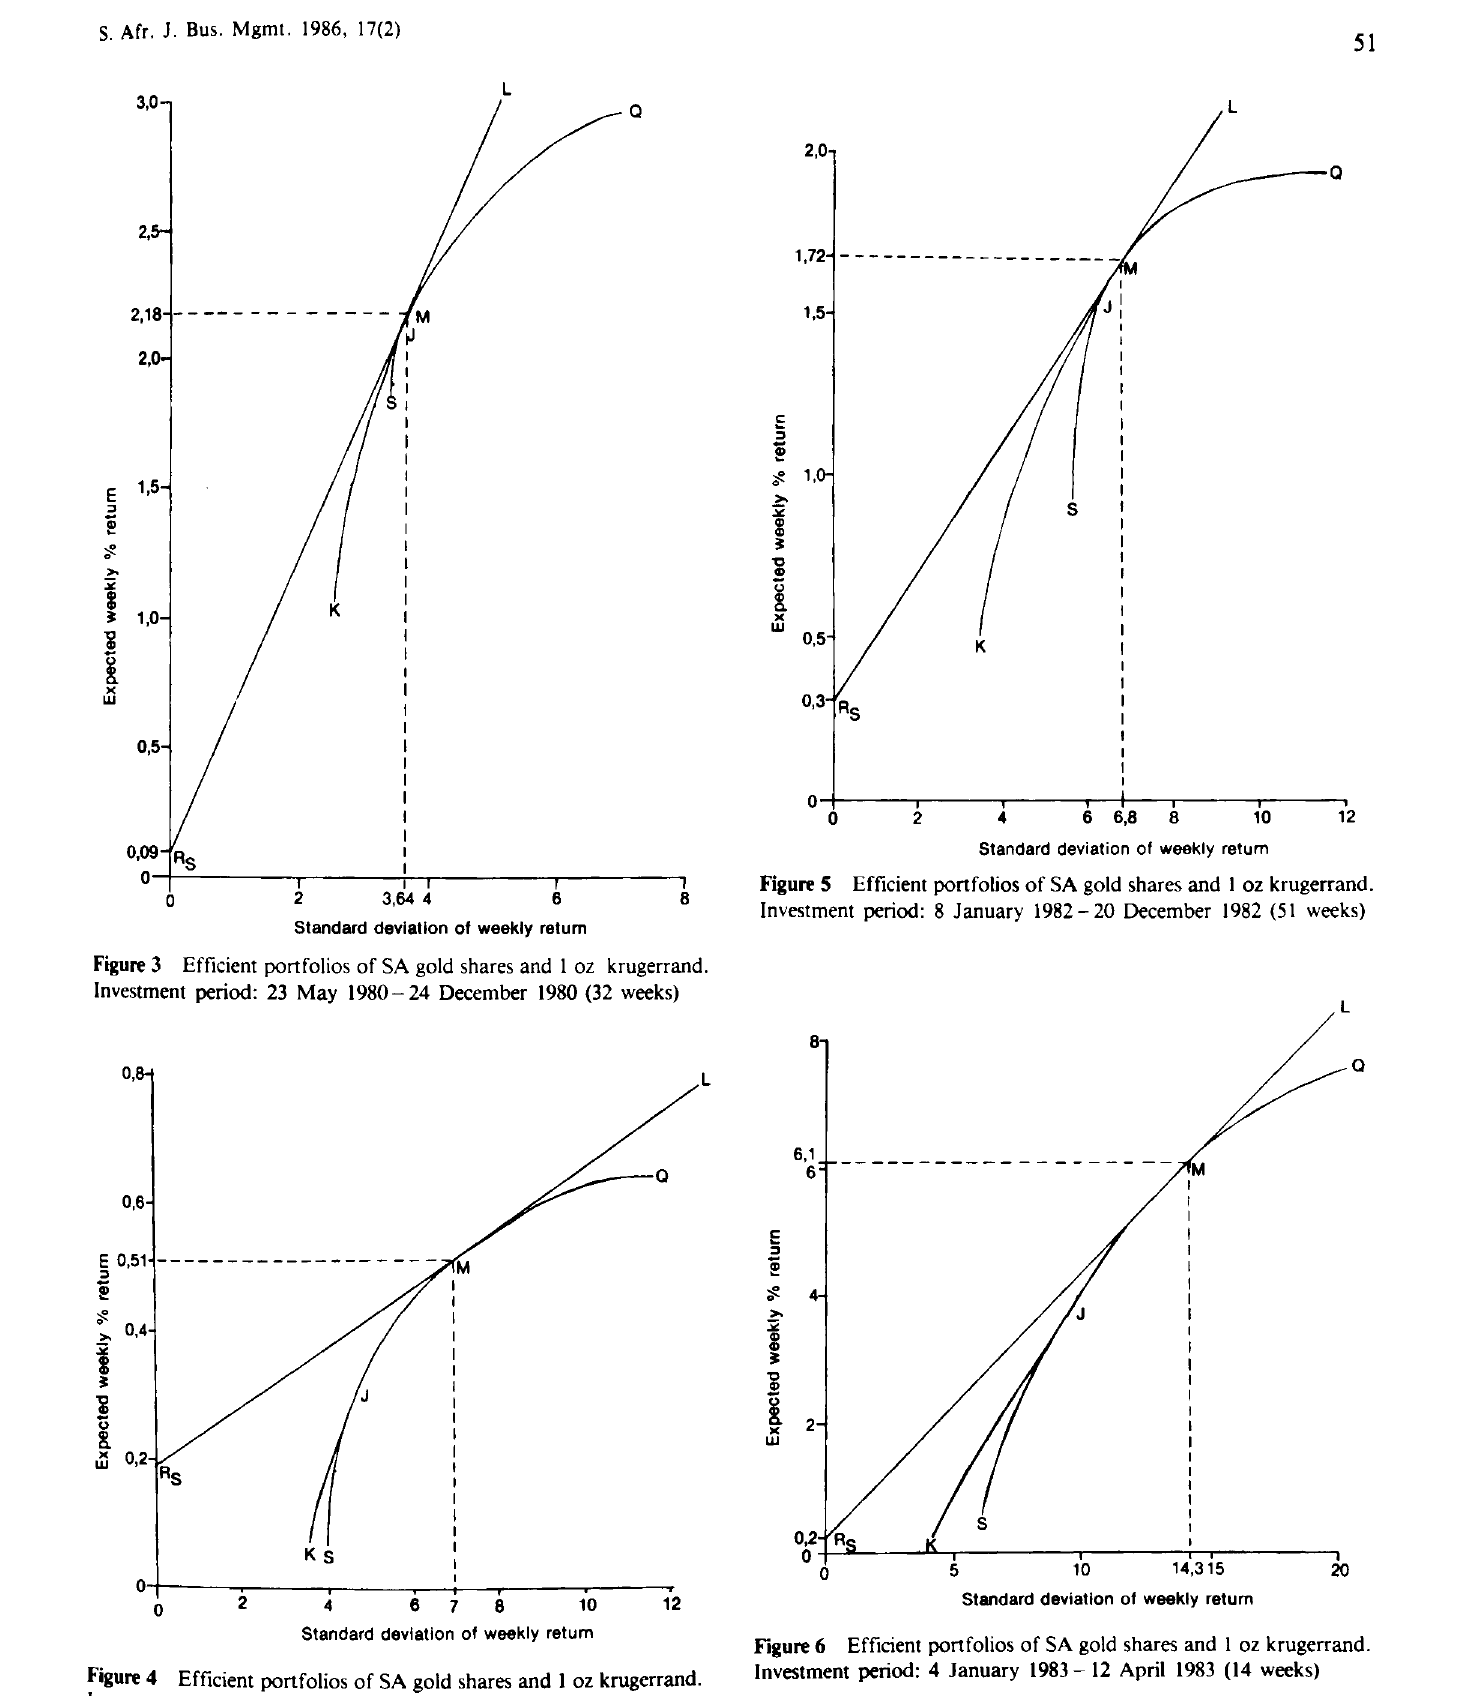
Figure 4 Efficient portfolios of SA gold shares and I oz krugerrand. Investment period: 8 January 1981 - 18 December 1981 (49 weeks)